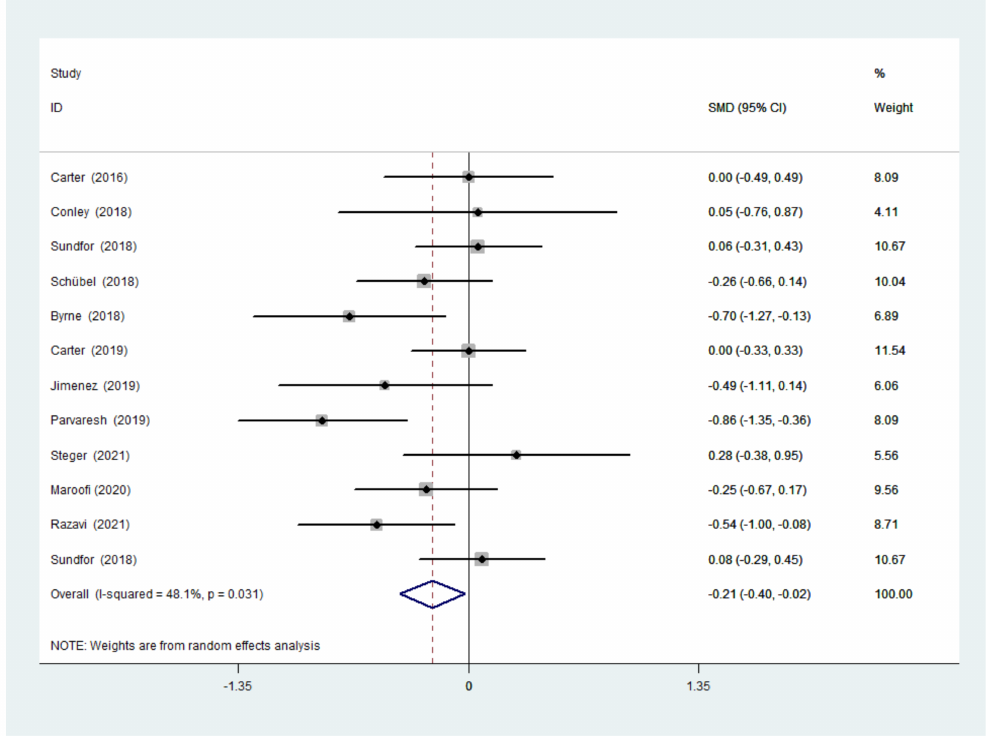
Figure 4. The weighted mean difference in body weight (kg) between the IF and CCR (SD: standard deviation; CI: confidence interval).